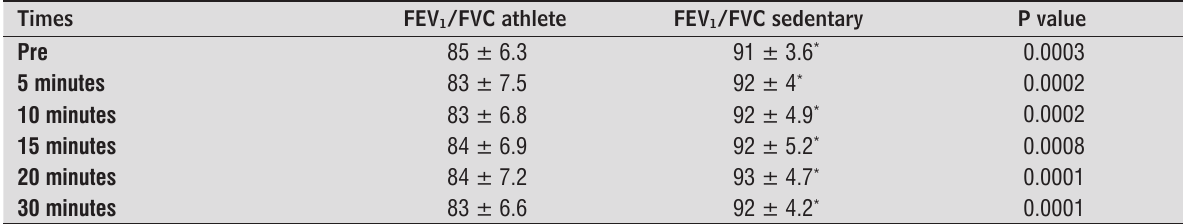
Table 3 - Comparison of the athlete and sedentary groups for FEV 20, and 30 minutes after the maximum stress test on the treadmill